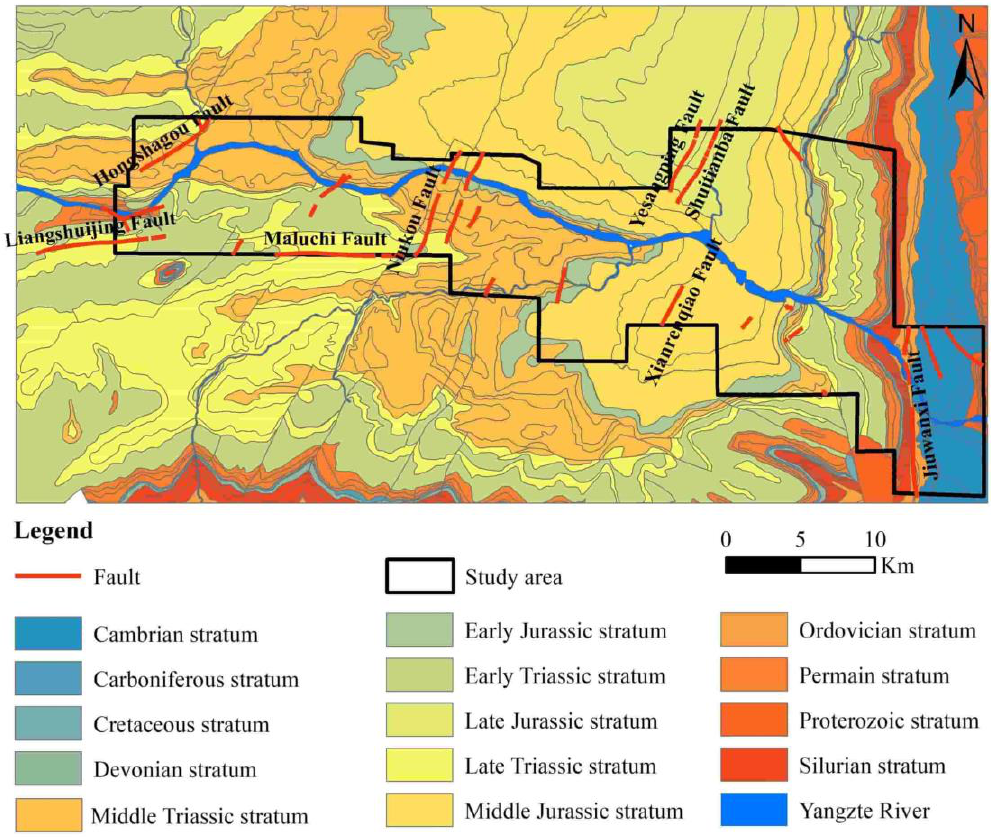
Figure 2. Geological map of the study area.